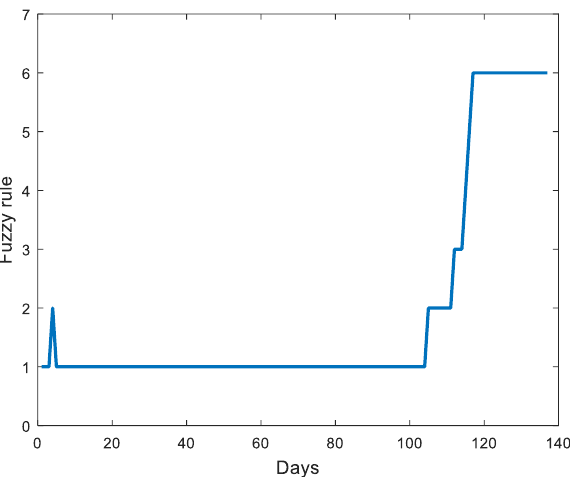
Figure 11. Fuzzy rule evolution of variance feature.